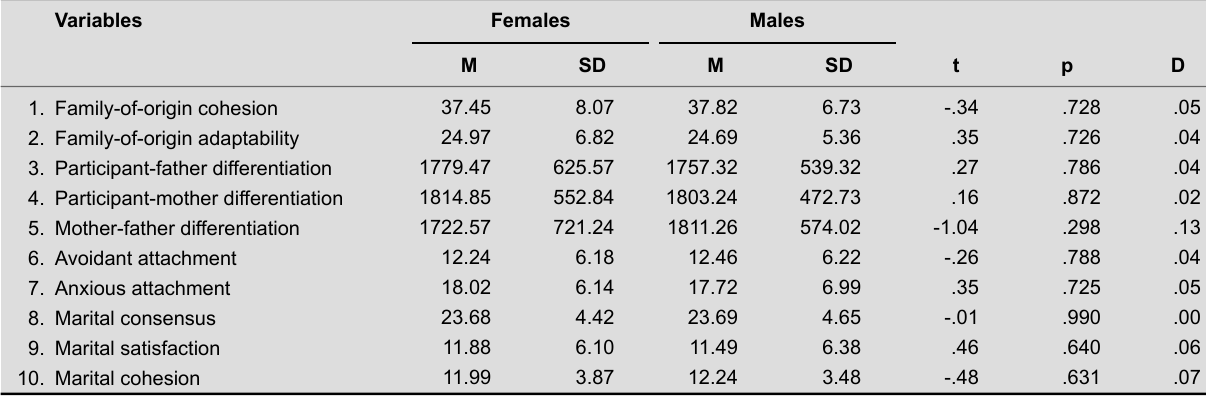
Gender Comparisons in Observed